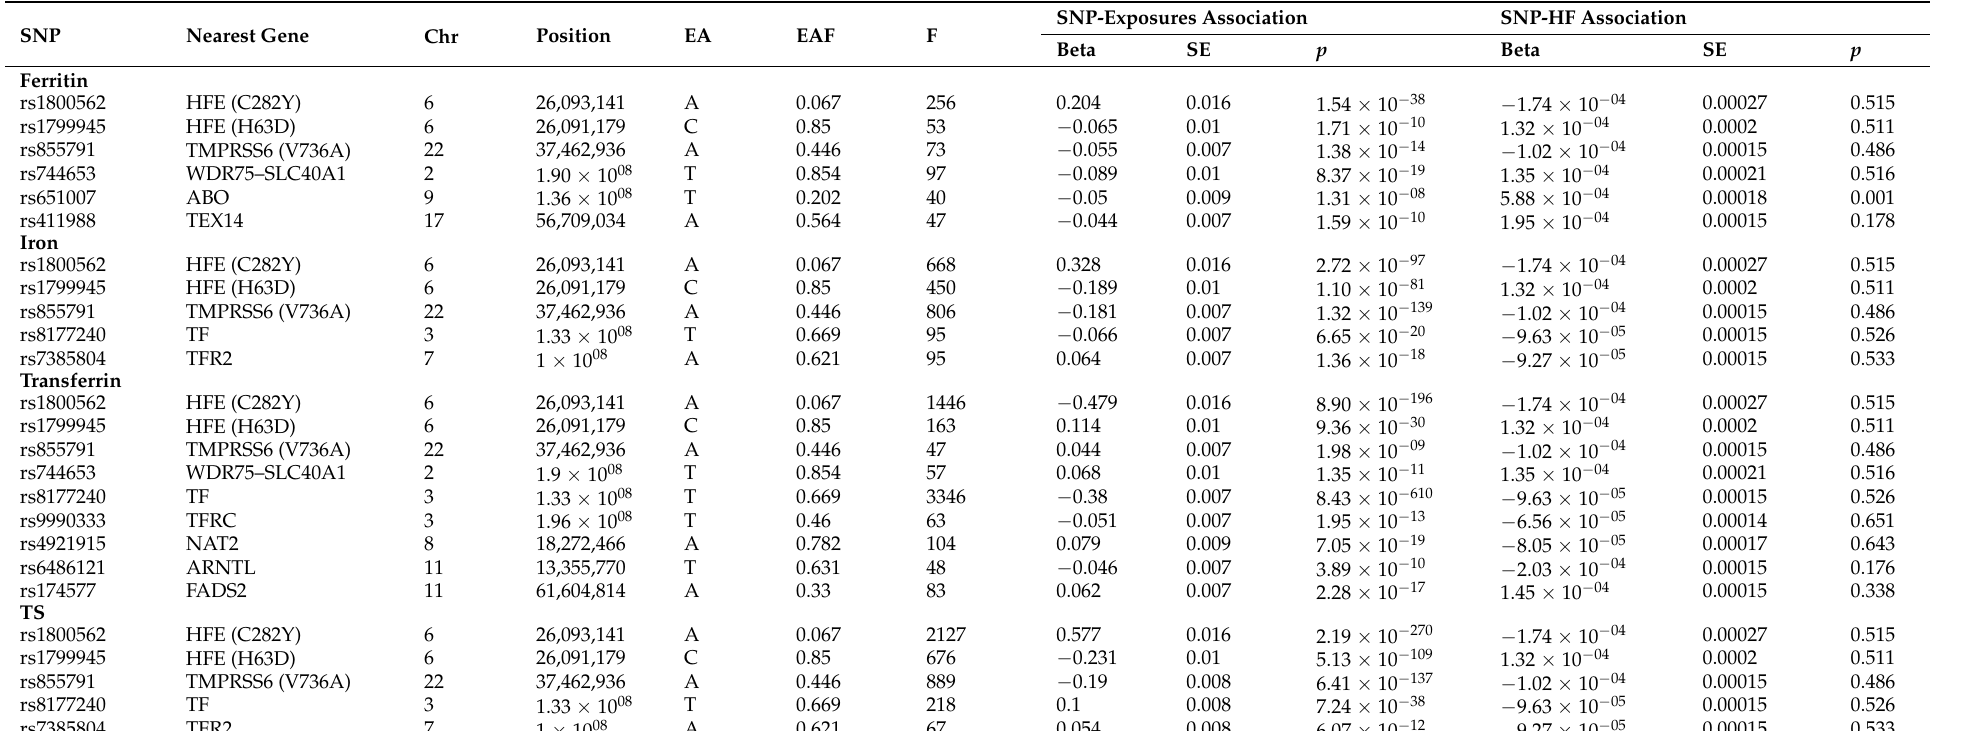
Table 1. The characteristics of SNPs and their associations with exposures and HF